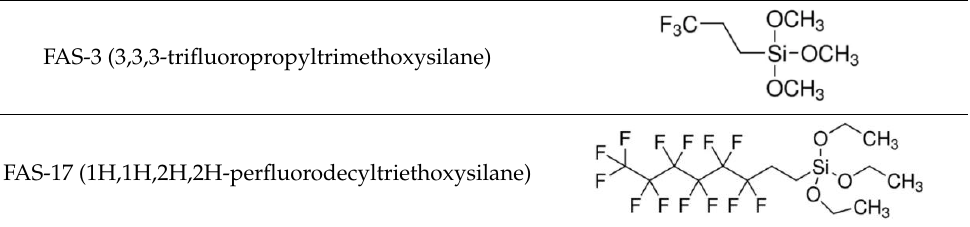
Table 3. Compounds inducing superhydrophobicity.